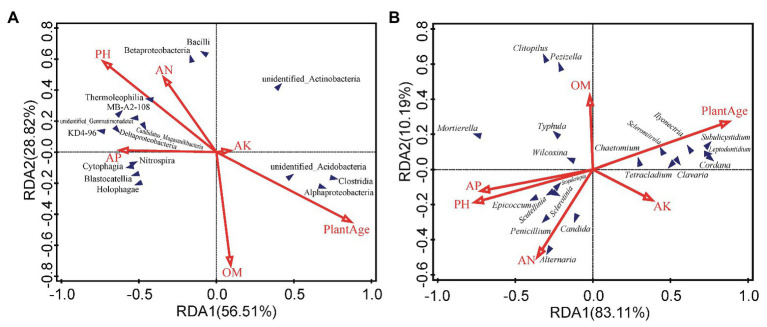
Redundancy analysis (RDA) to measure the linkage between variables of soil microbial community and soil factors, based on the relative abundance of bacterial classes (A) and fungal genera (B). OM, organic matter; AN, available nitrogen; AP, available phosphorous; and AK, available potassium.